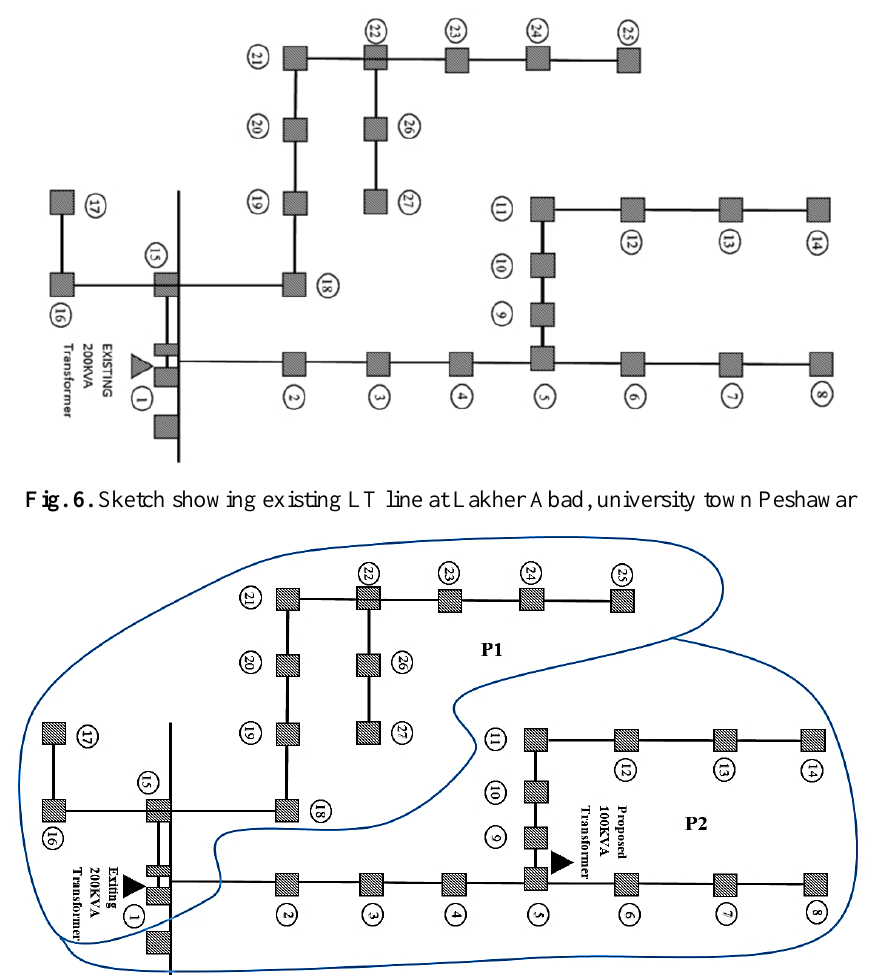
Fig. 7. Sketch showing proposed LT line at Lakher Abad, university town